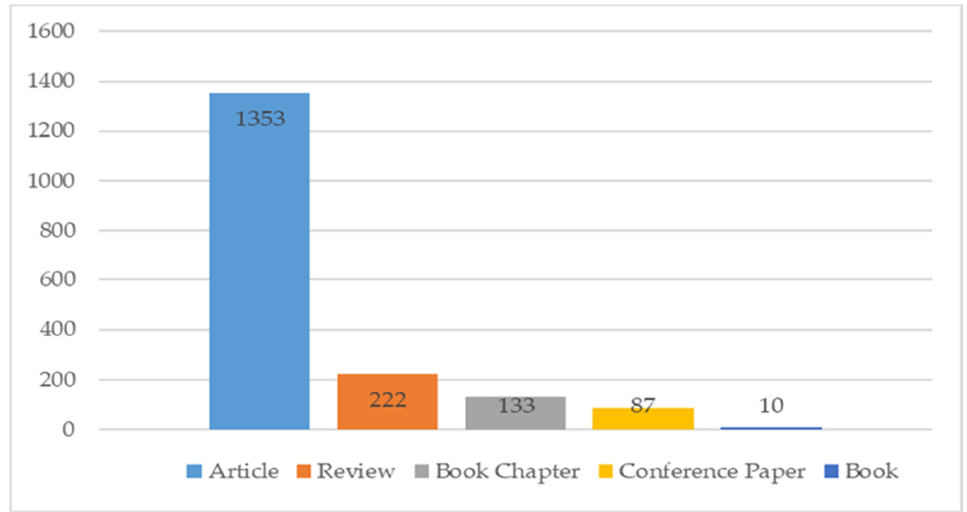
Figure 4. Type of the selected documents.